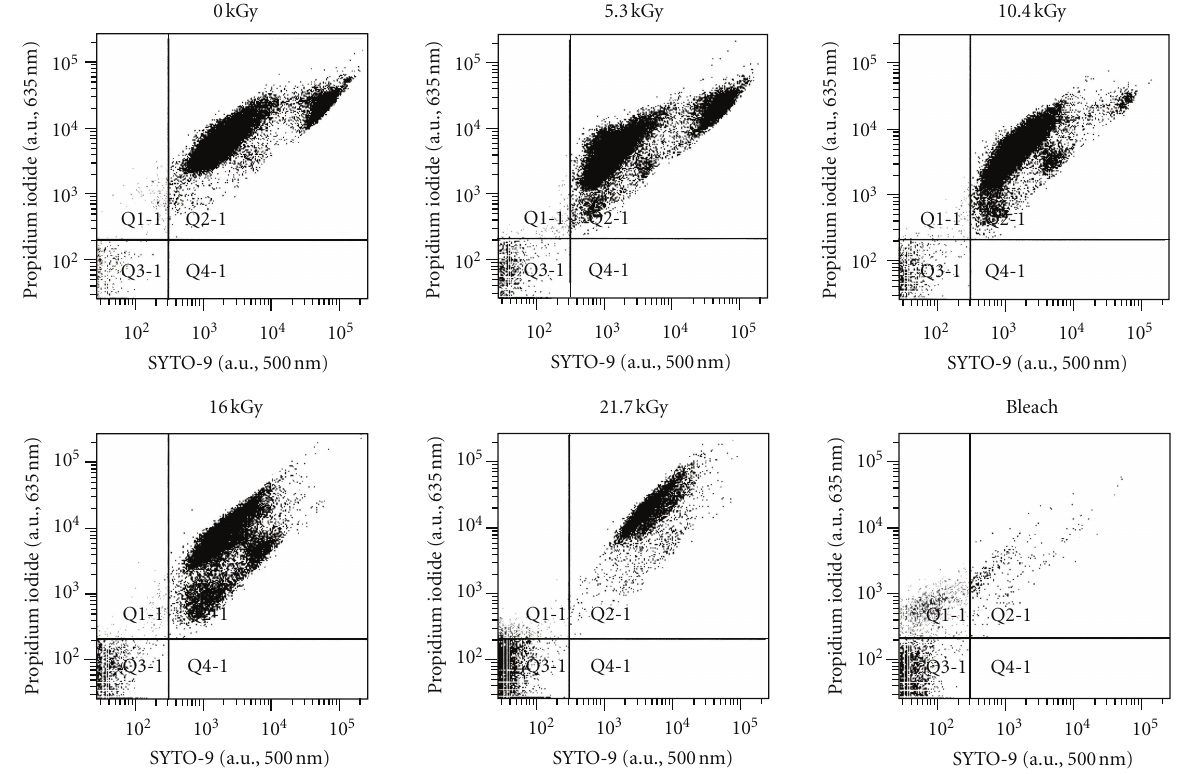
Figure 4: Representative FACS scatter plots of B. atrophaeus spores stained with propidium iodide and SYTO 9. Spores were exposed to various doses of EB irradiation (listed above respective scatter plots) or 50% hypochlorous acid prior to assessment of fluorescent dye